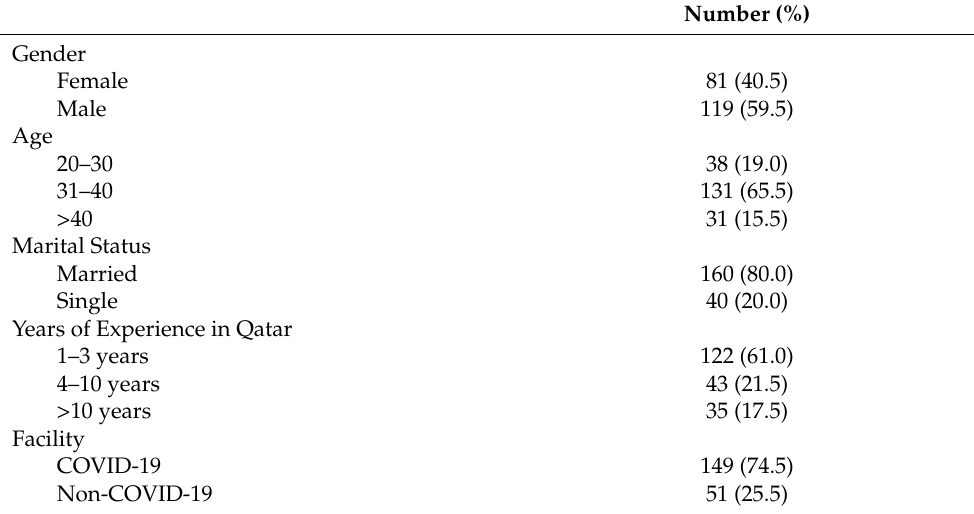
Table 1. Characteristics of